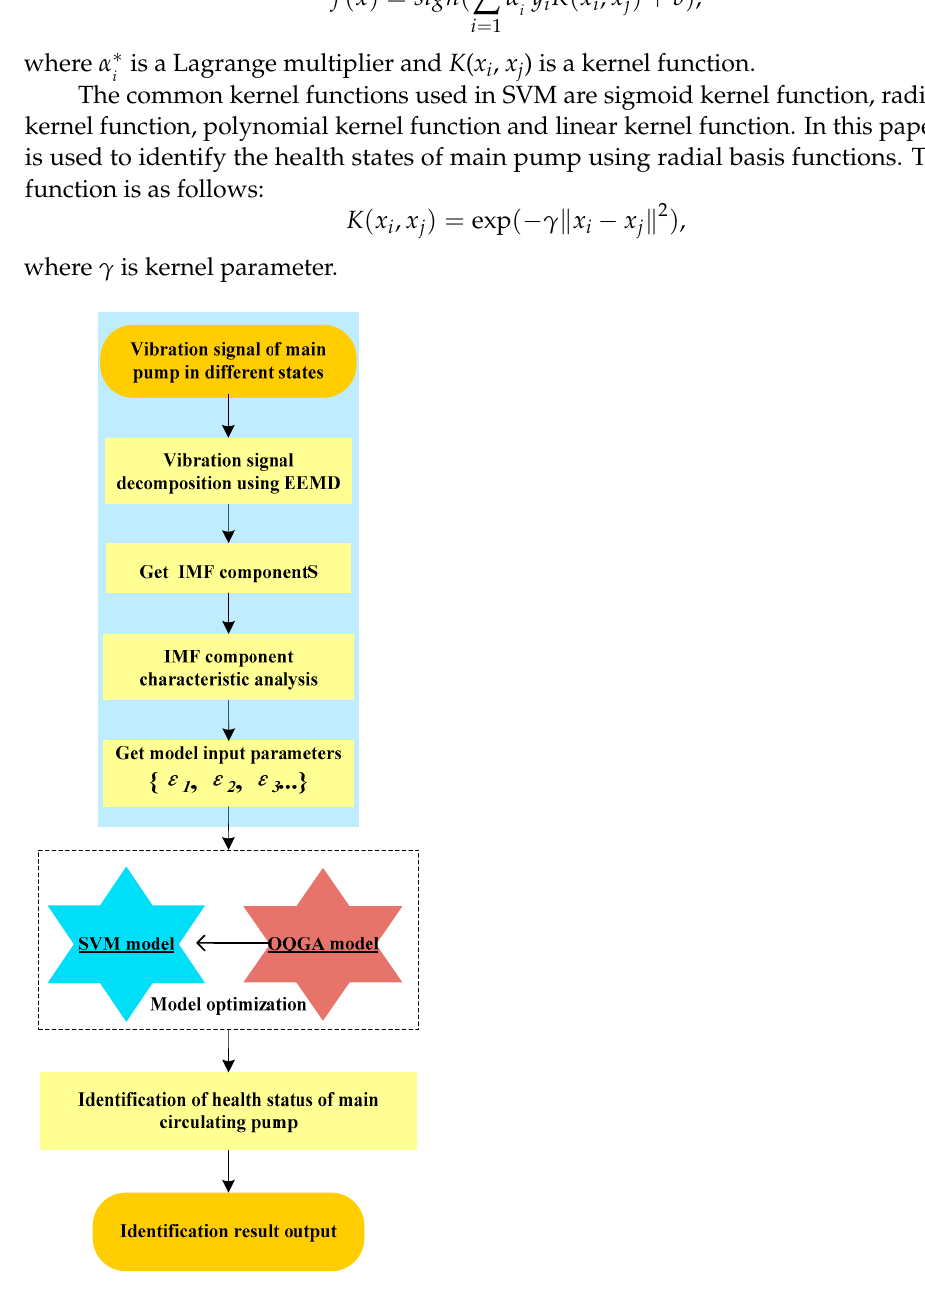
Figure 8. Overall block diagram of the main pump health state identification.